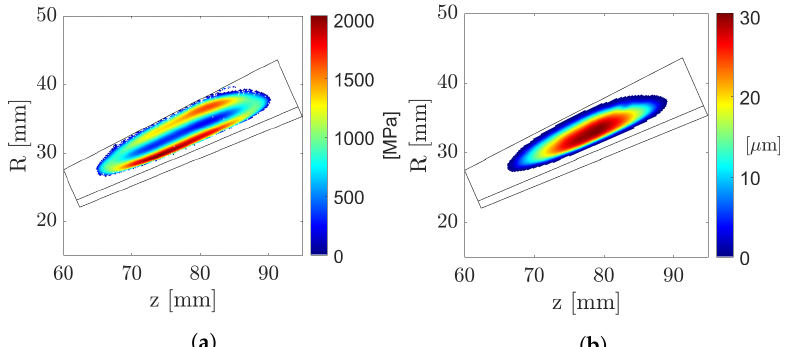
Figure 10. Pinion patterns after 30 M cycles. Only one geometry update is performed. ( a ) Contact pattern. ( b ) Wear pattern.